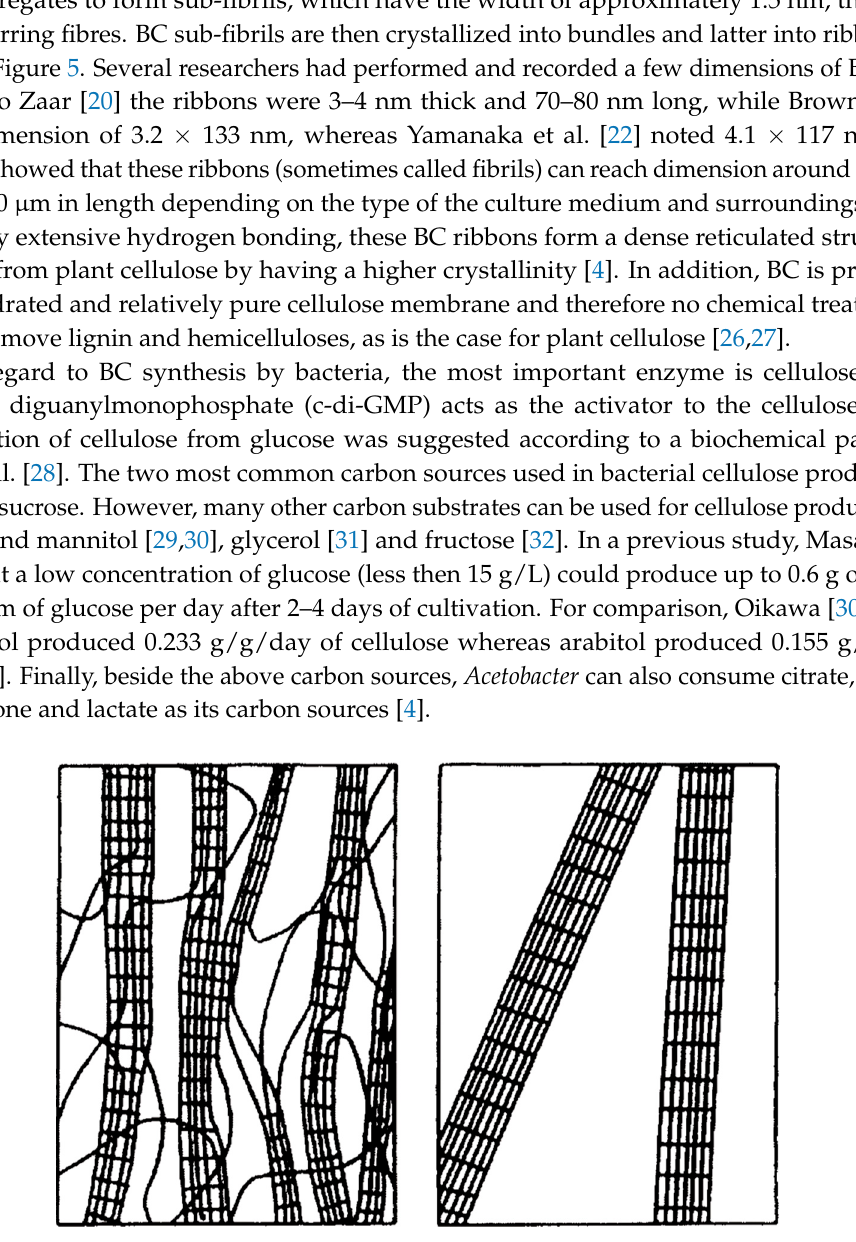
Figure 4. Schematic model of bacterial cellulose (BC) microfibrils ( right ) drawn in comparison with the ‘fringed micelles’ of plant cellulose fibrils ( left ) (adapted from [18], with permission from © 2000 Springer).